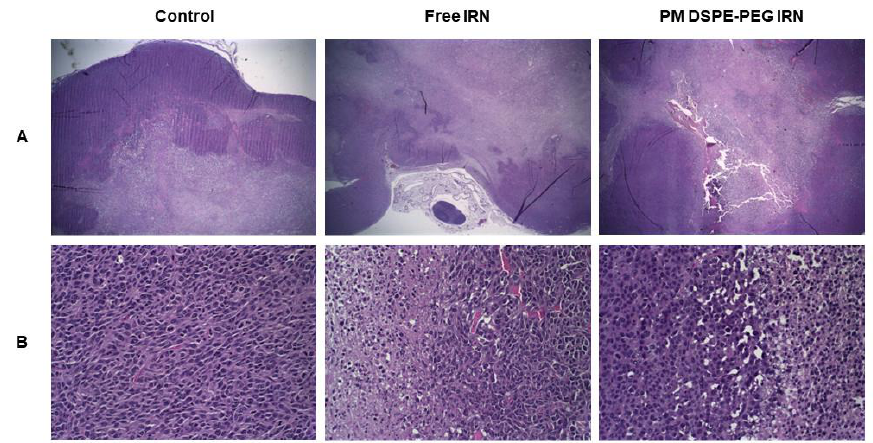
Figure 6. Histopathological analysis of tumor from CT26 colorectal tumor-bearing female BALB/c mice treated with saline (control), free IRN, or PM DSPE-PEG IRN stained by hematoxylin and eosin (H&E). ( A ) Original magnification 2 × and ( B ) magnification 40 × .